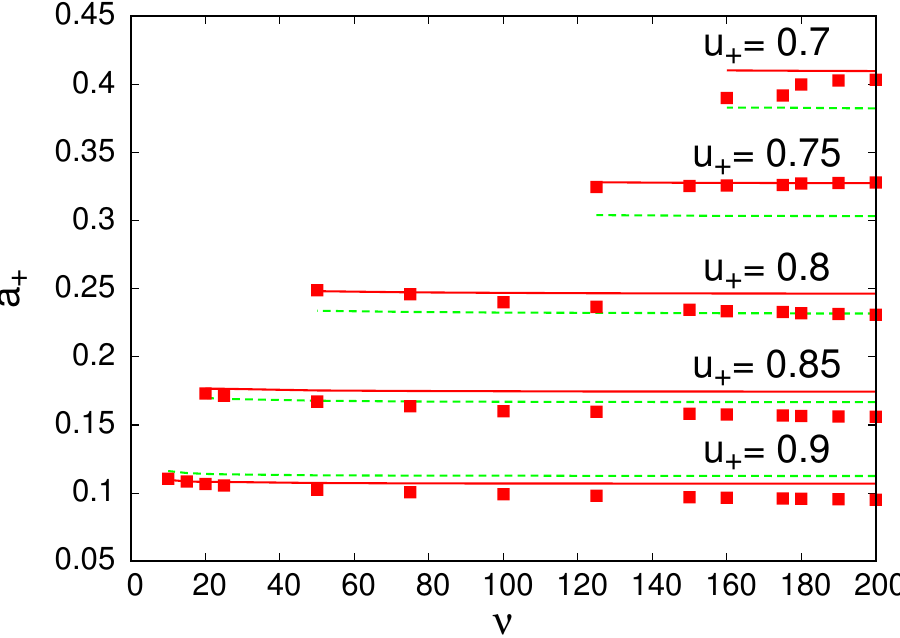
Figure 4. Comparison between lead wave amplitude a + of PDSW and RSDW with numerical solutions of the nematic Equations (11) and (12) with the initial condition (13). Numerical amplitude: red squares; amplitude (45) with m = 1 given by undular bore solution of eKdV Equation (42): red (solid) line; amplitude given by undular bore solution of Kawahara equation (Equation (42) with c 1 = c 2 = c 3 = 0): green (dashed) line. Here, u − = 1.0 and q =